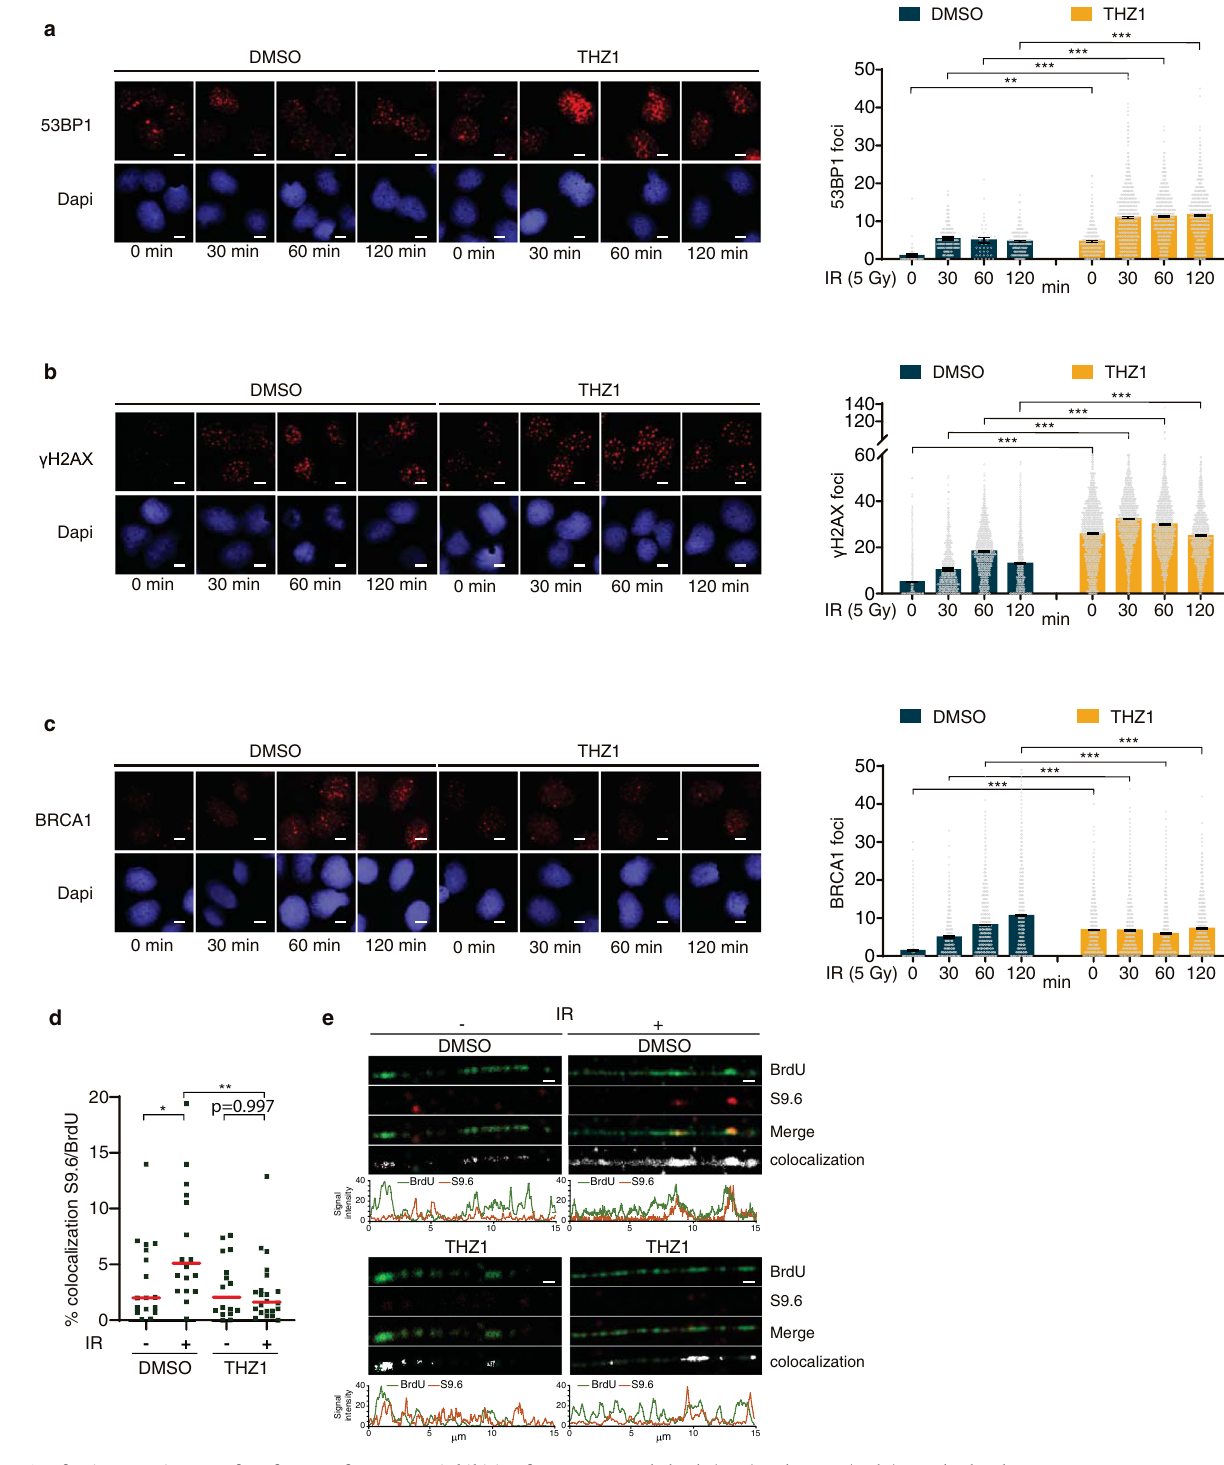
hybrids(S9.6)andssDNA(BrdU)signalcolocalizationonresectiontractsgenerated in non- and 5 Gy-irradiated HeLa cells. p value were calculated using multiple comparison with Ordinary One-Way ANOVA. * p =0.036 and ** p =0.002. At least n =15 fi elds examined over 3 independent experiments were quanti fi ed. e Representativequanti fi cationsof fi berpro fi lesforDNAresectedtrack(BrdU)and RNA:DNA hybrids (S9.6) staining intensities from non- and irradiated HeLa cells treated with RNAPII inhibitor, THZ1 (1 μ M 2h). N =3 independent experiments. Scale bar: 1 μ m. Source data are provided as a Source data fi